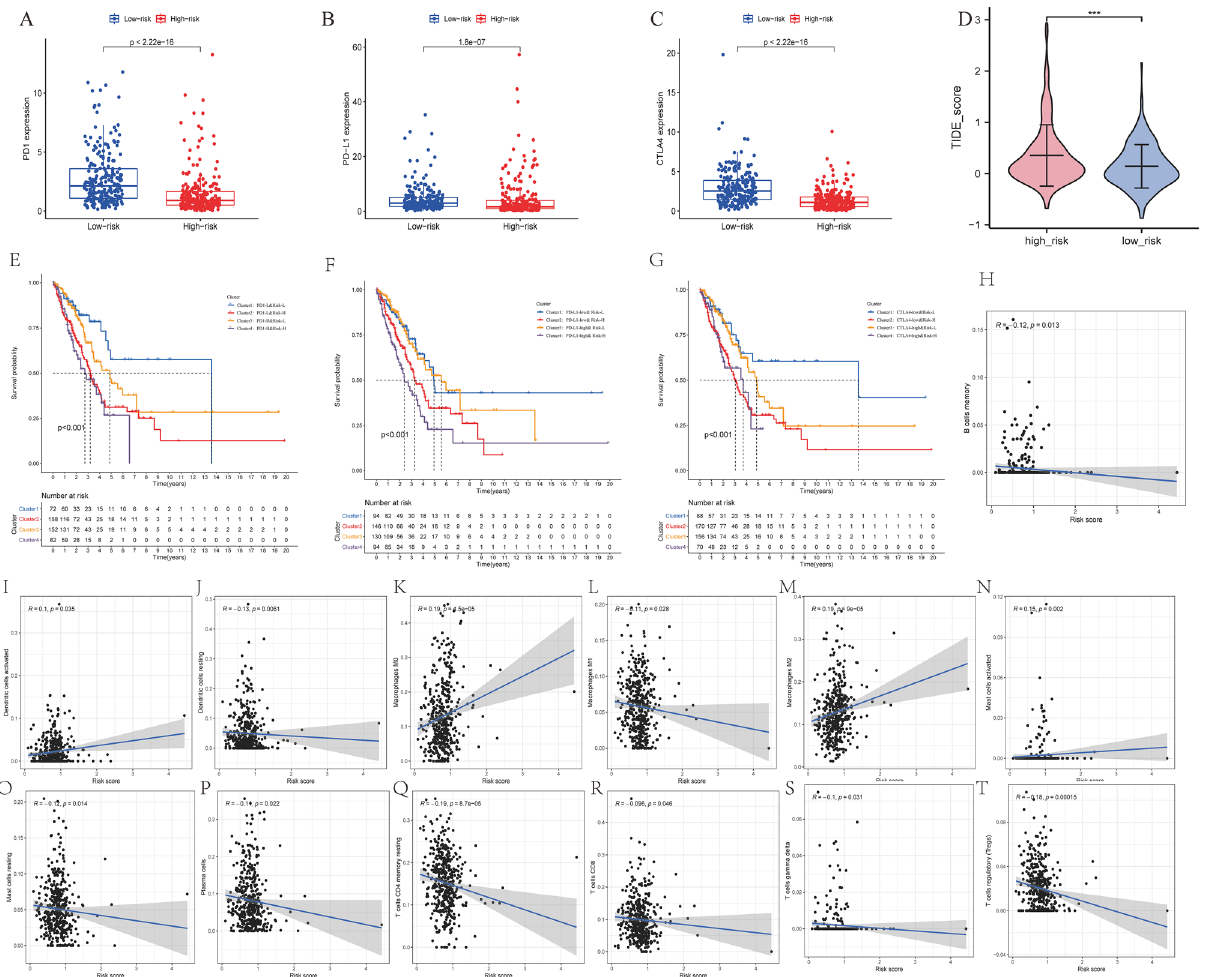
Figure 9. Estimation of immune checkpoint gene expression and cancer immunotherapy response with the model in the entire TCGA cohort. ( A – C ) Boxplot showing the differences in PD1, PD-L1, and CTLA4 expression between the high- and low-risk groups. ( D ) TIDE prediction score between the high- and low-risk patients. ( D ) Kaplan–Meier survival curves of the four patient groups stratified by the IClncRNA model and PD-1 ( E ), PD-L1 ( F ), and CTLA-4 ( G ). ( H – T ) Correlation between the risk score and immune